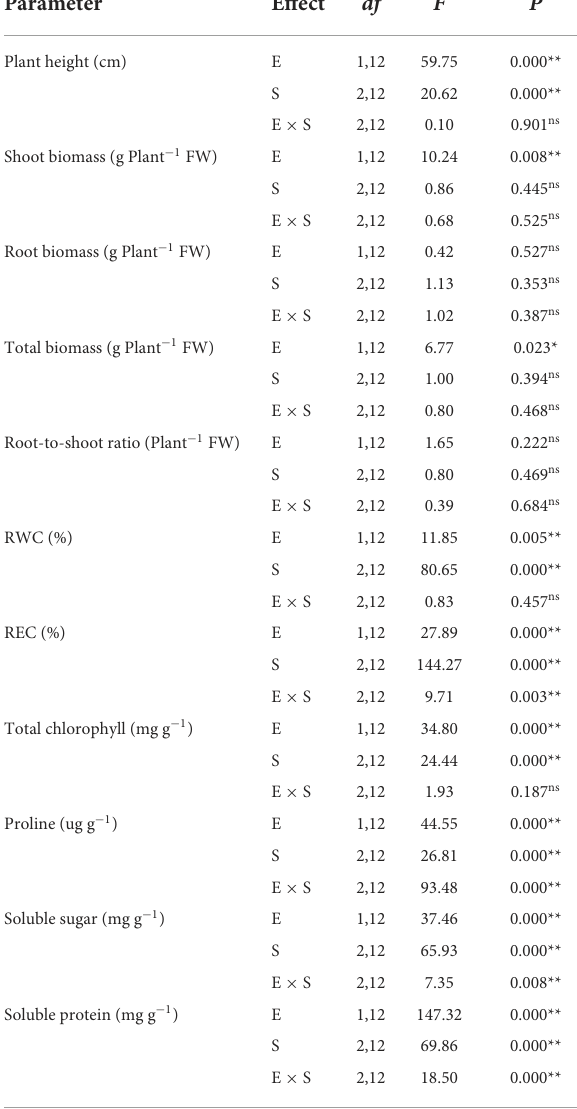
TABLE 1 Analysis of variance for the effects of E. bromicola on barley development and physiological response under salt stress conditions.